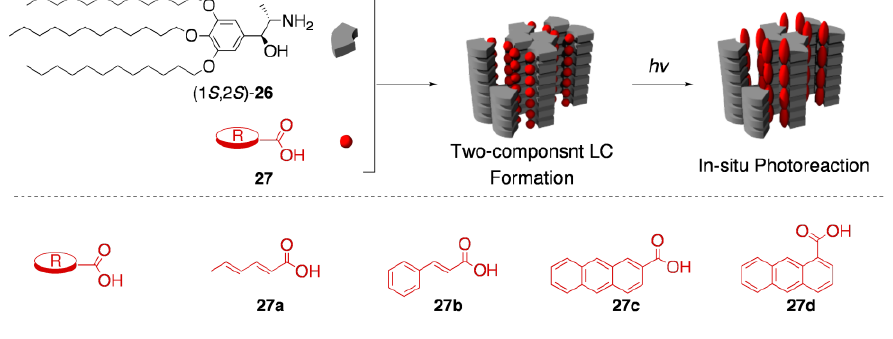
Figure 11. Schematic representation of the photoreaction within two-component LC